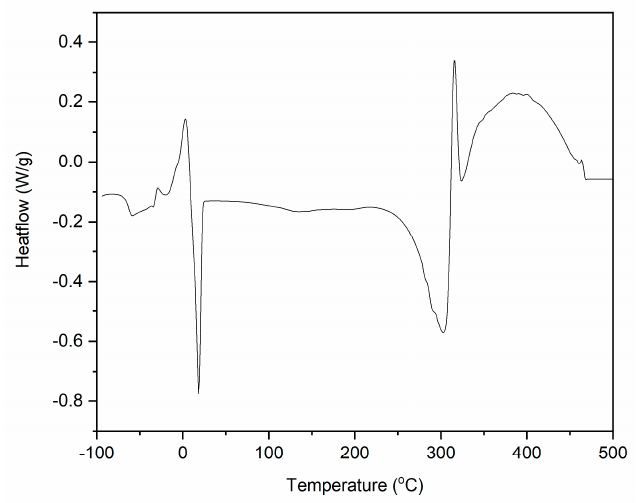
Table 5. Differential Scanning Calorimetry ( DSC) analysis of DmiBr (T g —glass transition, T cc —cold